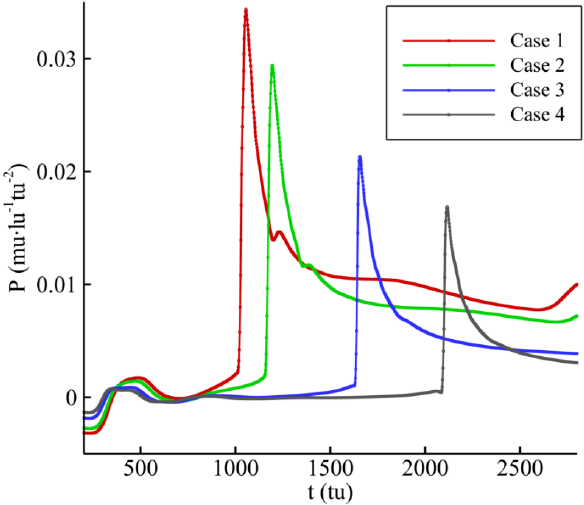
Figure 8. The evolution of pressure at point P in Cases 1–4.